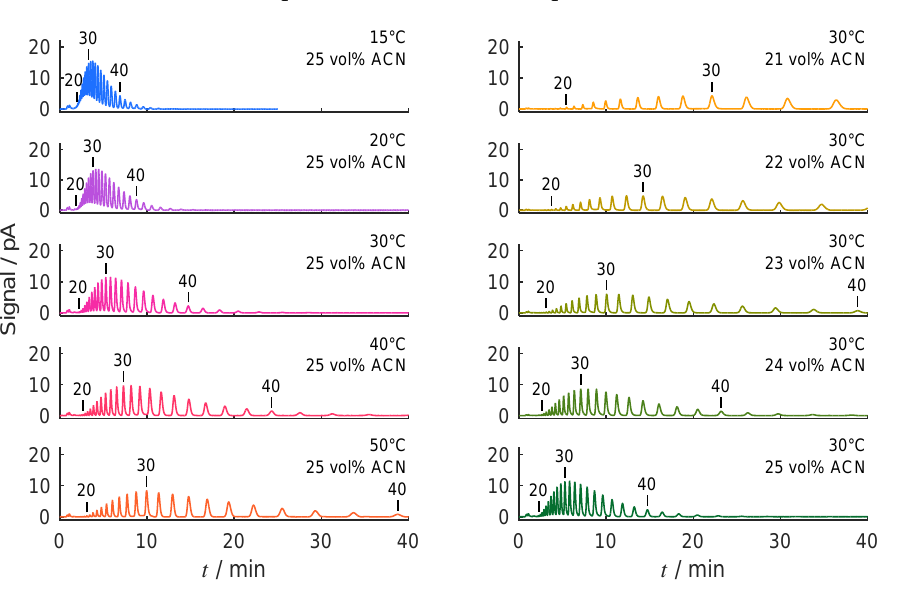
Figure 1. Example chromatograms demonstrating the roles of temperature and mobile phase com- position for the separation of PEG1400. For better orientation, peaks are marked for the homologs with n = 20, 30, and 40, respectively. Left —five different temperatures (15, 20, 30, 40, 50 ◦ C), using 25vol % acetonitrile (ACN) in water as eluent. Right —five different eluent compositions (21, 22, 23, 24, and 25vol % ACN in water) at 30 ◦ C. Remark: The chromatogram in the left (middle) is the same as the one in the right